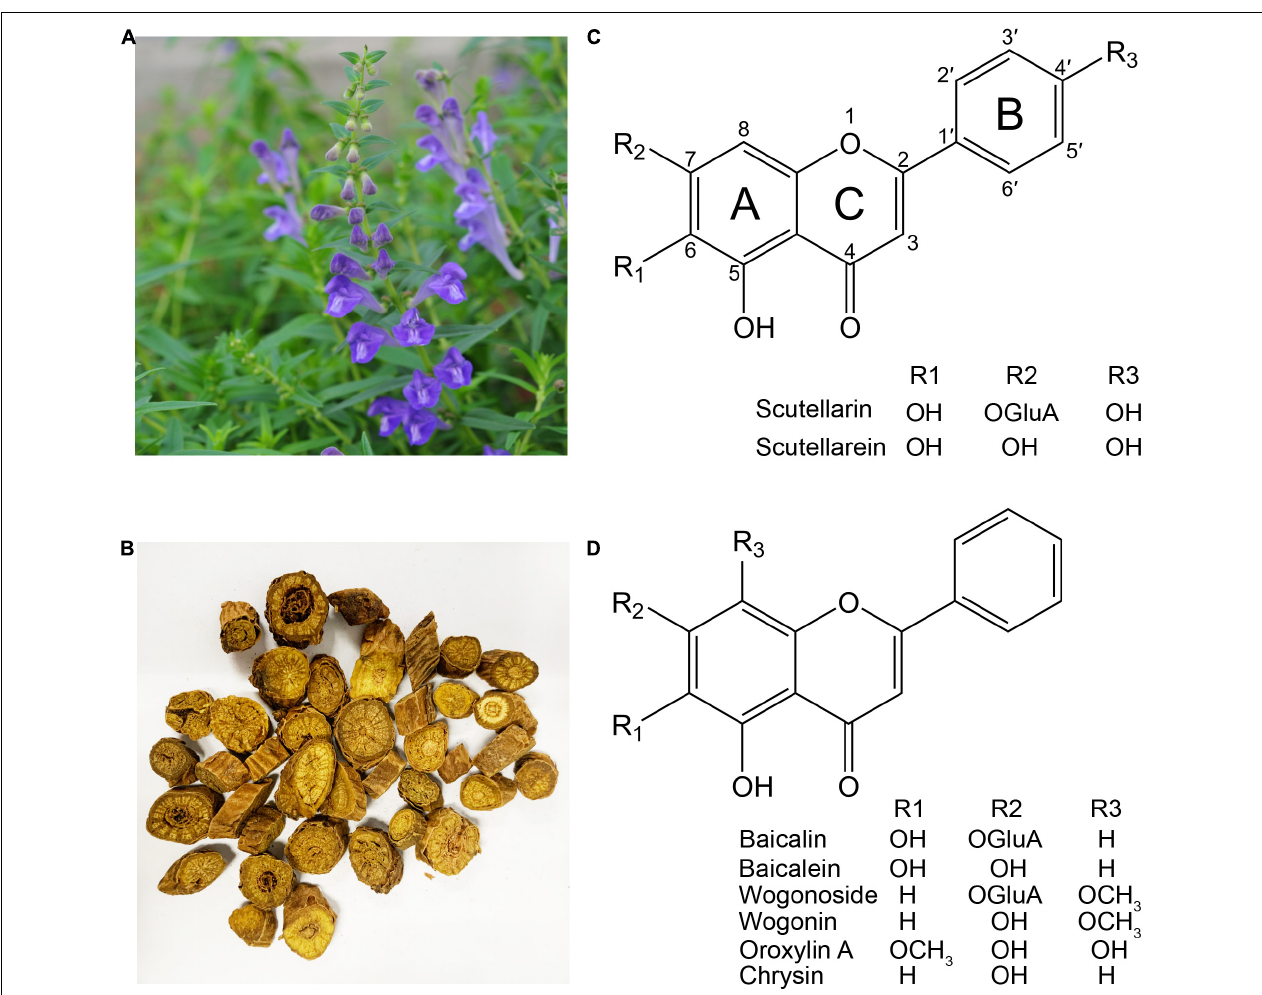
FIGURE 1 | The medicinal plant Scutellaria baicalensis and its major flavones. (A) S. baicalensis plant. (B) The dried roots of S. baicalensis used in traditional Chinese medicine. (C) Structure of flavones produced from naringenin. (D) Structure of 4 (cid:48) -deoxyflavones derived from pinocembrin.